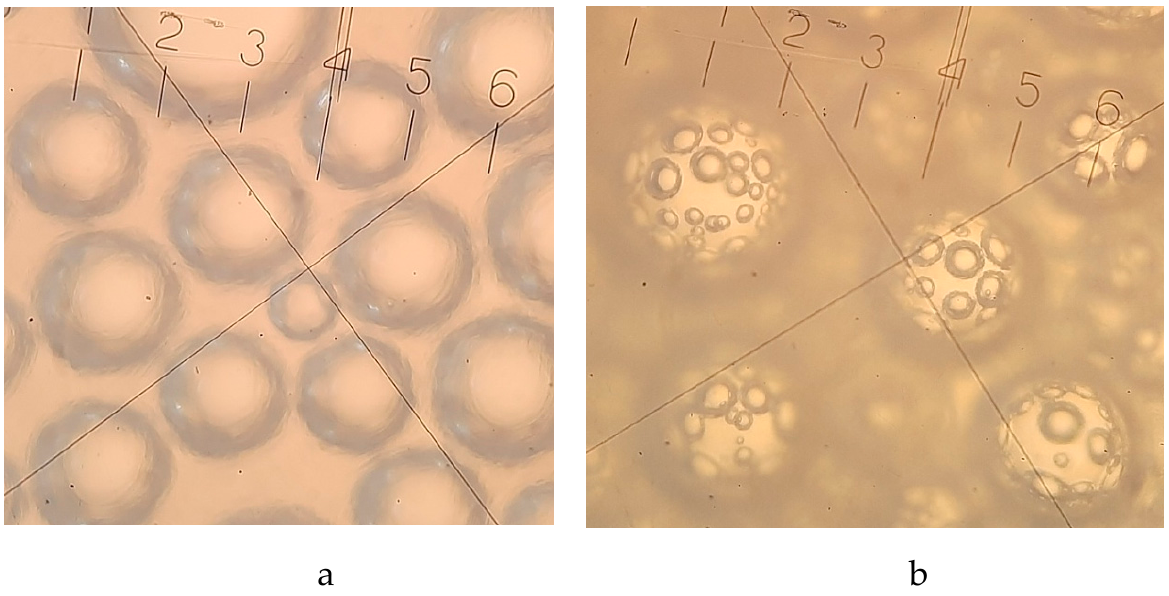
a b Figure 4. Microstructure of milk–vegetable ice cream: a -without β -glucan, b -with 1% oat β - Figure 4. Microstructure of milk–vegetable ice cream: a - without β -glucan, b - with 1% oat β -glucan glucan [12].